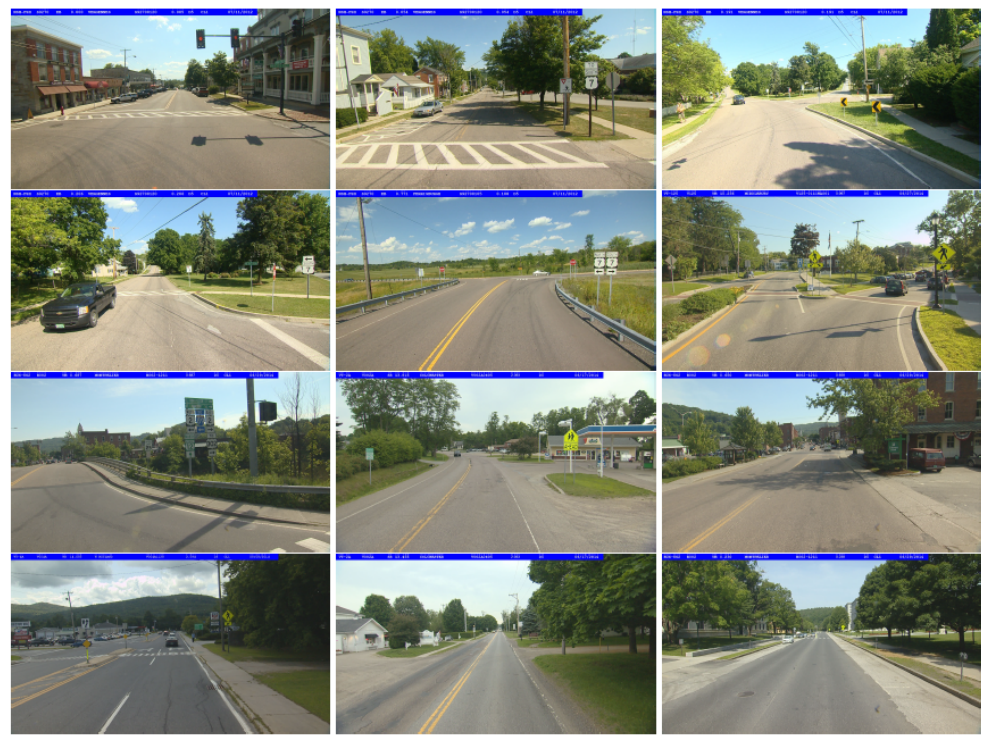
Figure 2. Sample images from the ARTSv2 dataset. The images contain a variety of sign types, often clustered very close together, which makes for challenging geo-localization. Environment and road types also vary